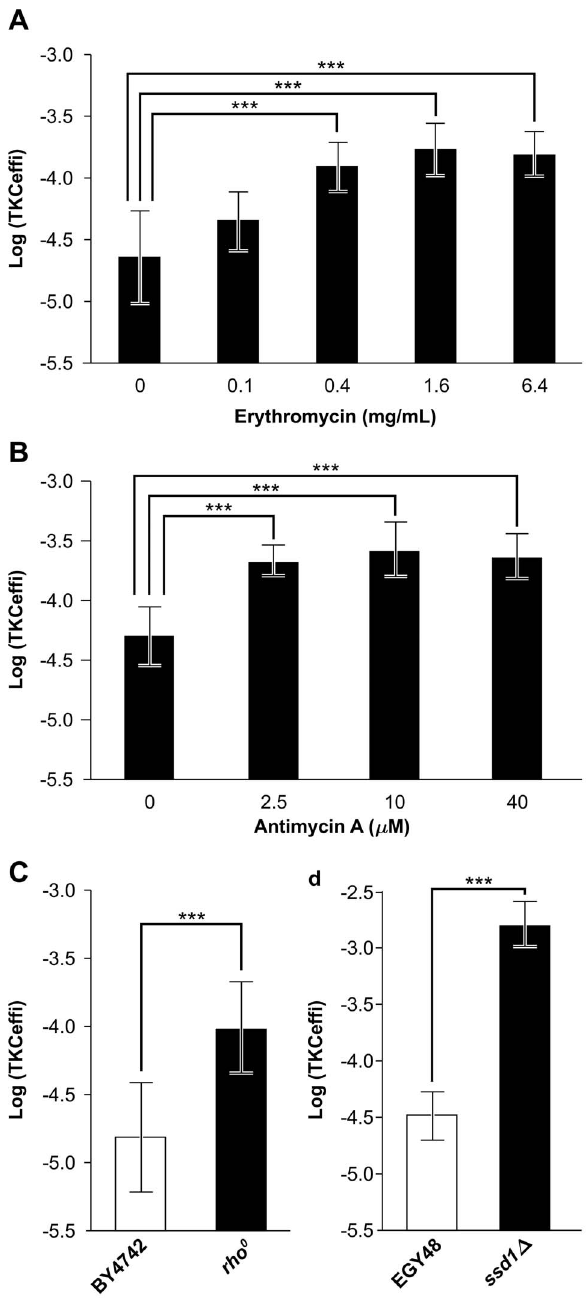
Figure 1. Effect of mitochondrial functional integrity and SSD1 mutation on efficiency of DNA transfer from Escherichia coli HB101 to Saccharomycescerevisiae strains (BY4742 in (A), (B) and (C); EGY48 in (D)) by trans-kingdom conjugation (TKC). Enhanced TKC efficiency was observed in (A) the pretreatment of the recipient yeast with a mitochondrial translational inhibitor, erythromy- cin; (B) the pretreatment of the recipient yeast with a mitochondrial respiration inhibitor, antimycin; (C) a rho 0 strain, lacking mitochondrial genome; and (D) an SSD1- knock-out mutant. The vertical axis ‘‘Log (TKCeffi)’’ represents the value of TKC efficiency (no. of transconjugant colonies/no. of recipient cell) converted to Log 10 . Data are represented as mean 6 SD (n=9 in A, B and D, 17 in C). Asterisks indicate a statistically significant difference: *** p , 0.001 (two-tailed t -test). HB101 (pRH210, pAY205) was used as the